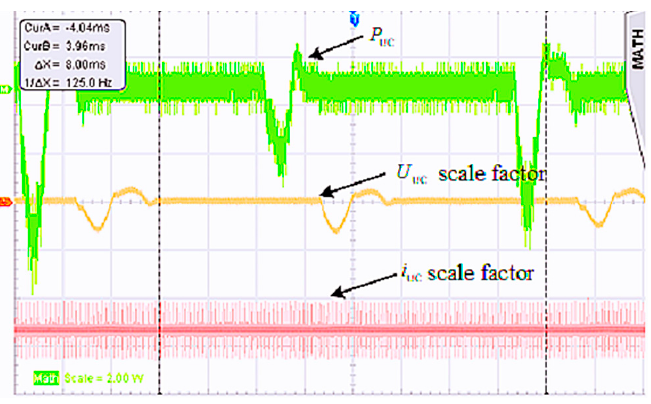
Figure 24. Super-capacitor power–voltage–current variation when accelerating.